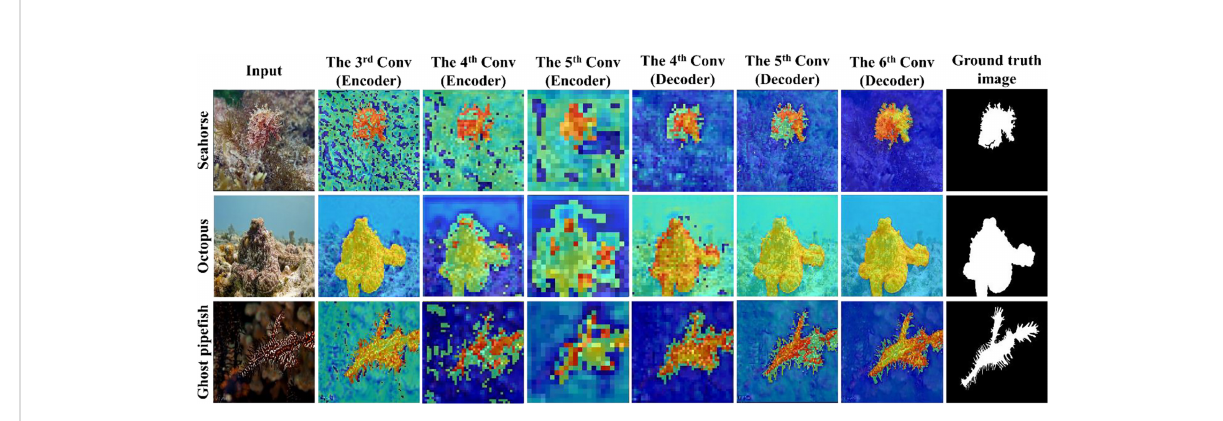
FIGURE 5 Examples of attention feature map with MAS3K dataset (case